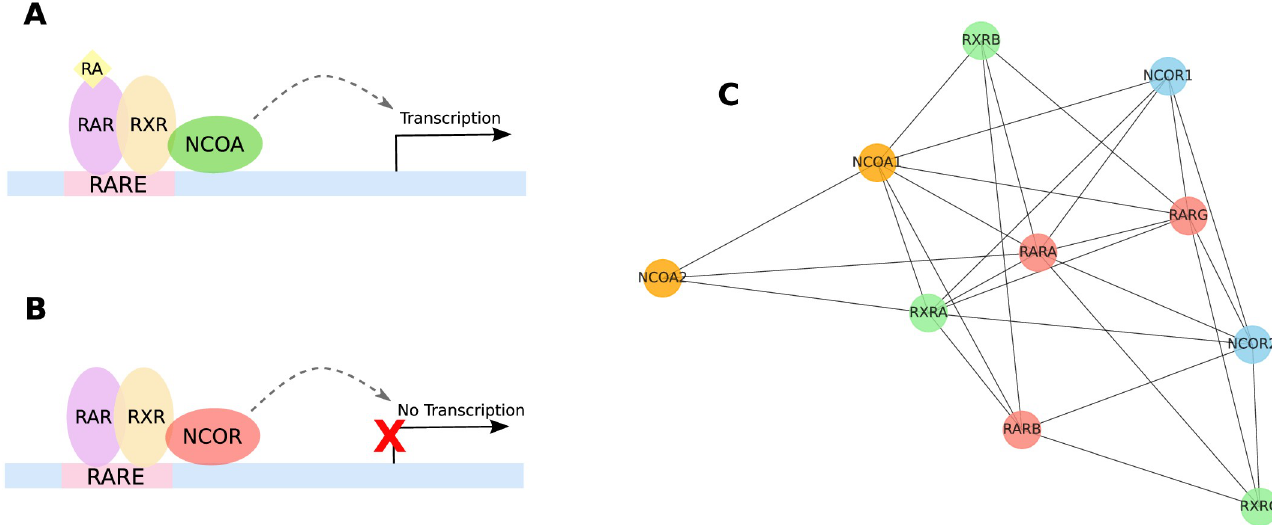
Fig 11. RAR/RXR pathway is an example of WGD importance. (A) In presence of Retinoid Acid (RA) the RAR/RXR complex recruits Nuclear CoActivators (NCOA), activating the transcription of the downstream gene. (B) In absence of RA the RAR/RXR complex recruits Nuclear CoRepressors (NCOR) instead, blocking the transcription of the downstream gene. (C) Protein-protein interactions among the genes involved in the RAR/RXR pathway, common interactions with other genes are not shown for clarity. Genes colored in the same way are WGD copies of a common ancestral gene.